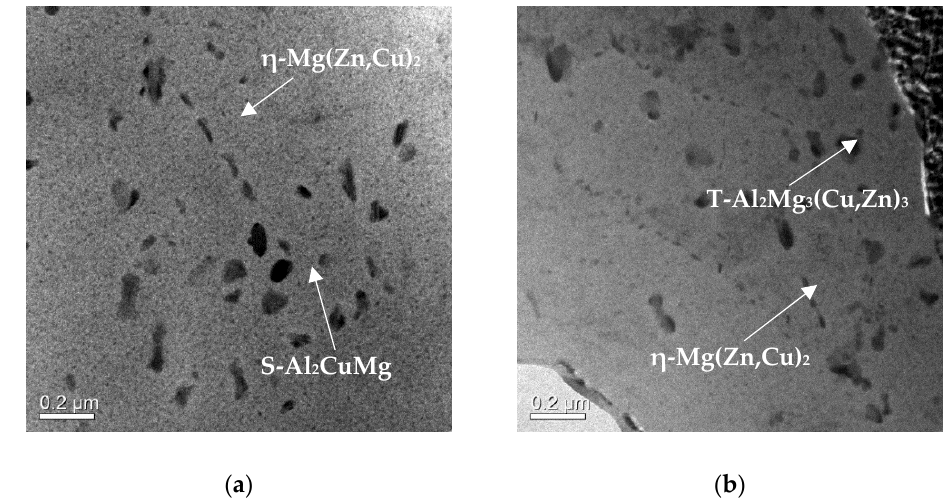
Figure 8. TEM micrograph of different samples: ( a ) RF50 and ( b ) HF50 after T73 heat treatment. Table 3. EDX Spectrum and Constituted Phases for Dispersoids in Different Samples. are 1.53 × 10 − 19 , 3.97 × 10 − 19 and 1.27 × 10 − 20 m 2 /s, respectively [28]. MgZn 2 forms initially